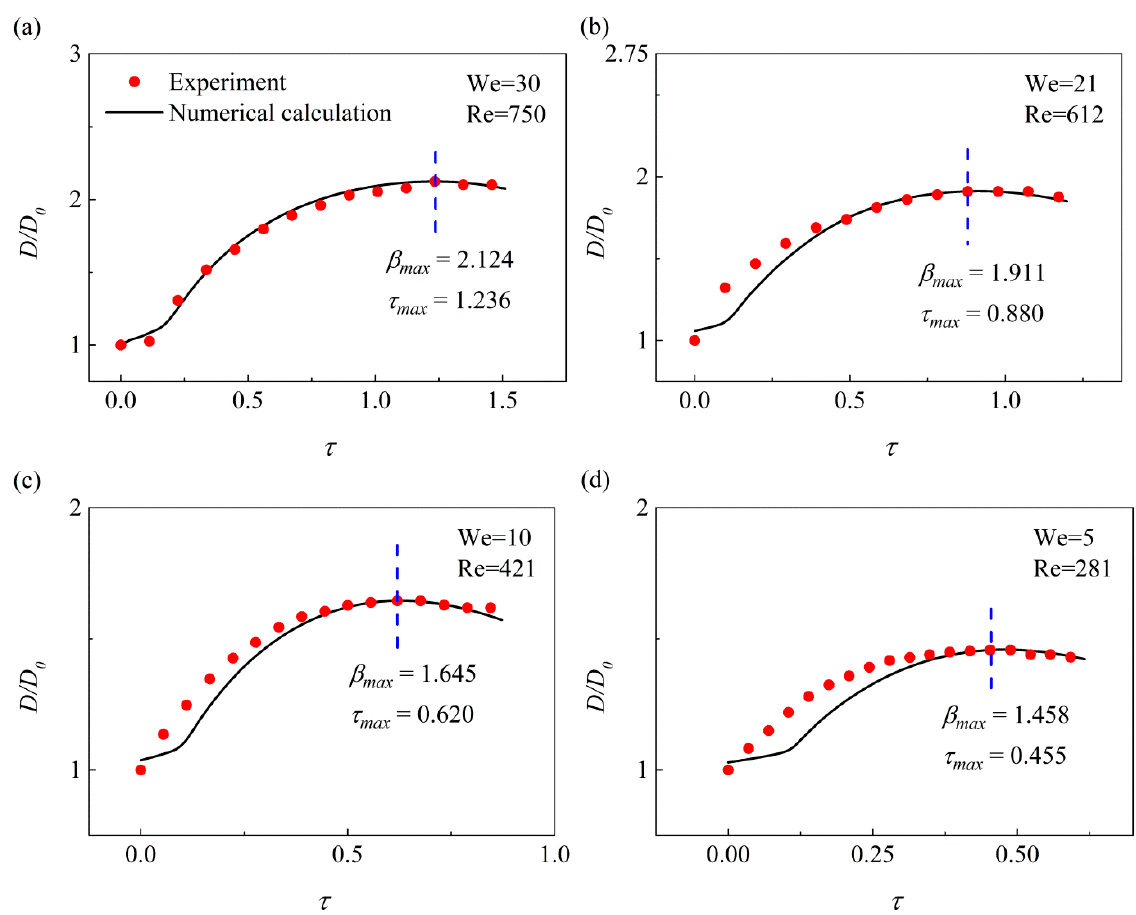
Figure 4. Comparison between the numerical calculation (denoted by the black solid line) and the experiment results (denoted by the red solid point) for the droplet non-dimensional diameter D / D 0 varied with non-dimensional time 𝜏 under 4 groups of impact parameters. ( a ) 𝑊𝑒 = 30 and 𝑅𝑒 = 750 , ( b ) 𝑊𝑒 = 21 and 𝑅𝑒 = 612 , ( c ) 𝑊𝑒 = 10 and 𝑅𝑒 = 421 , ( d ) 𝑊𝑒 = 5 and 𝑅𝑒 = 281 .